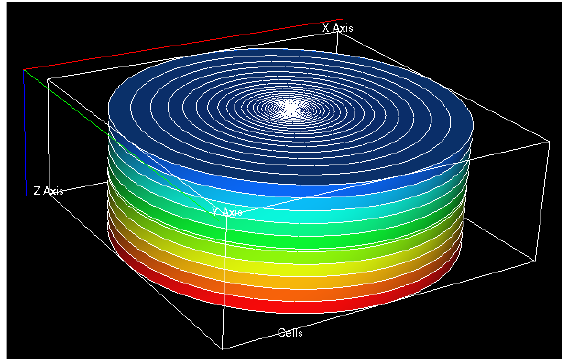
Figure 2—Reservoir model with visible fracture in the middle